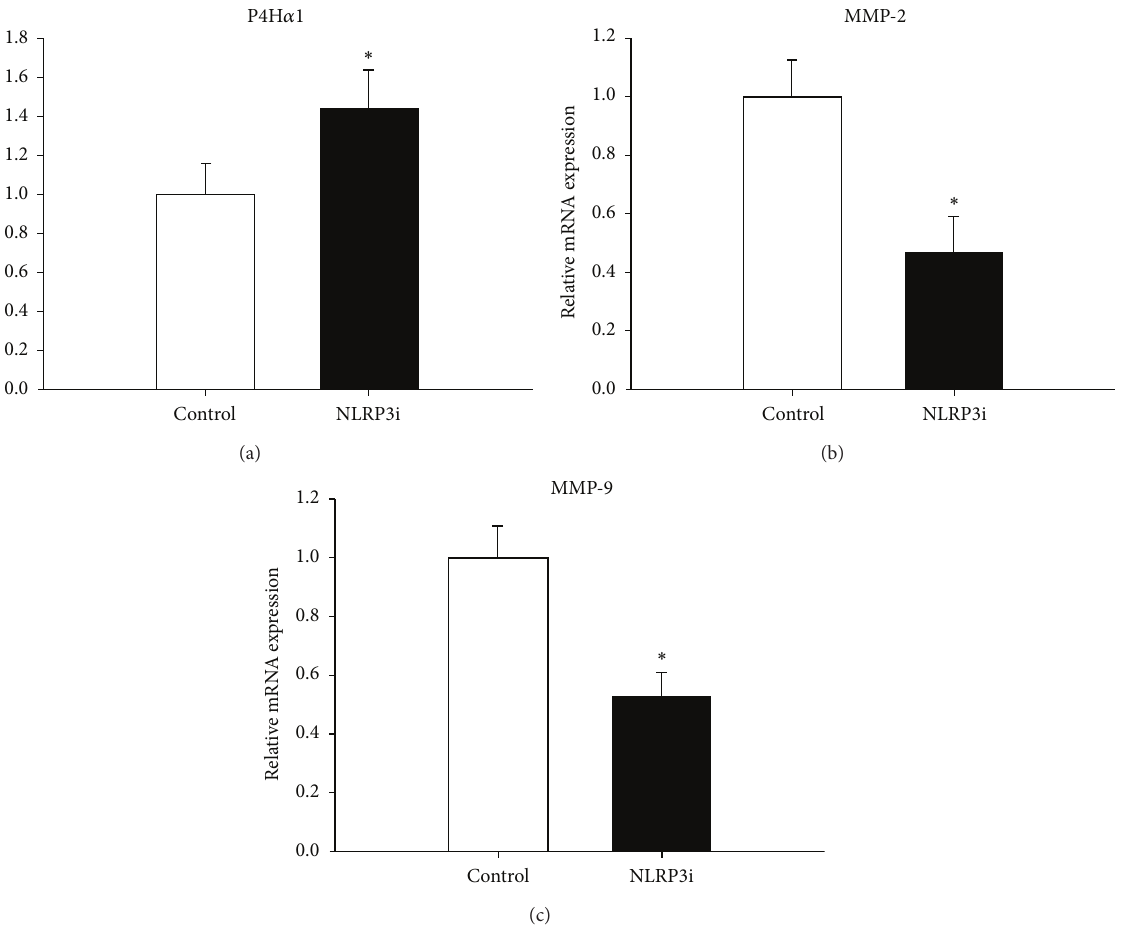
Figure 4: P4H 𝛼 1, MMP-2, and MMP-9 mRNA levels in aortas of ApoE-deficient mice were determined with real-time PCR. The mRNA expression of P4H 𝛼 1 was markedly higher in the NRLP3i group than in the control group, and the mRNA expression levels of MMP-2 and MMP-9 were significantly lower in the treatment group than the control group. ∗ 𝑃 < 0.05 versus control. Values are mean ±